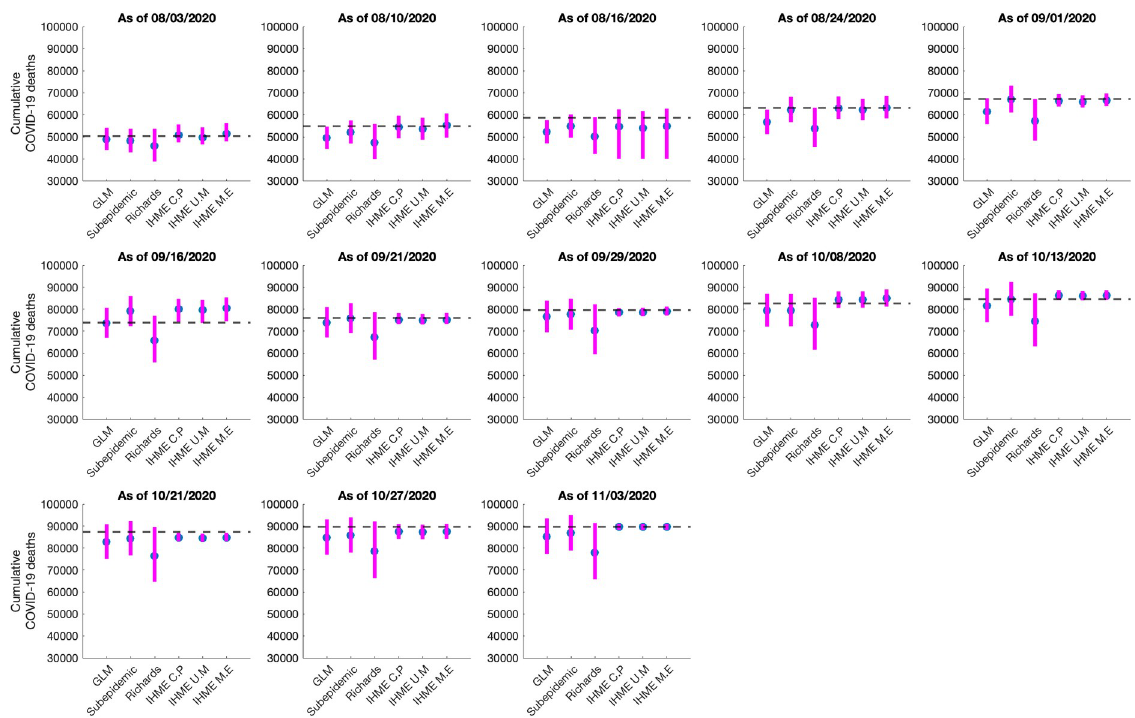
Fig 6. Systematic comparison of six models (GLM, Richards, sub-epidemic model, IHME current projections (IHME C.P), IHME universal masks (IHME U.M) and IHME mandates easing (IHME M.E) to predict the cumulative COVID-19 deaths for Mexico in the thirteen sequential forecasts. The blue circles represent the mean deaths, and the magenta vertical line indicates the 95% PI around the mean death count. The horizontal dashed line represents the actual death count reported by that date as published in the November 11, 2020, IHME estimates